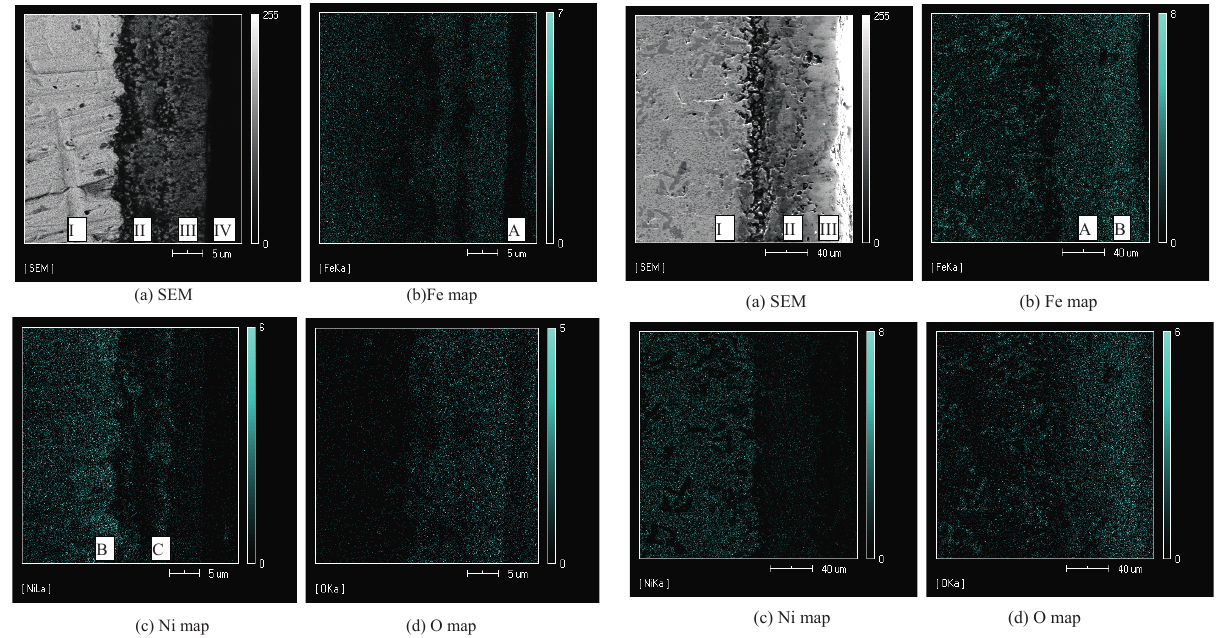
Figure 8. Cross-sectional morphology of oxide scale of 50Fe-50Ni alloy oxidized at 950 ı